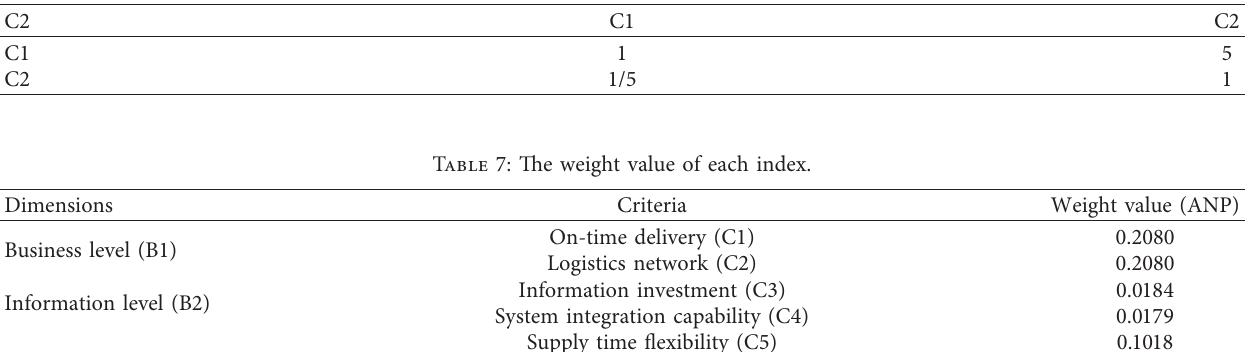
Table 6: The judgment matrix under risk response ability (C3).